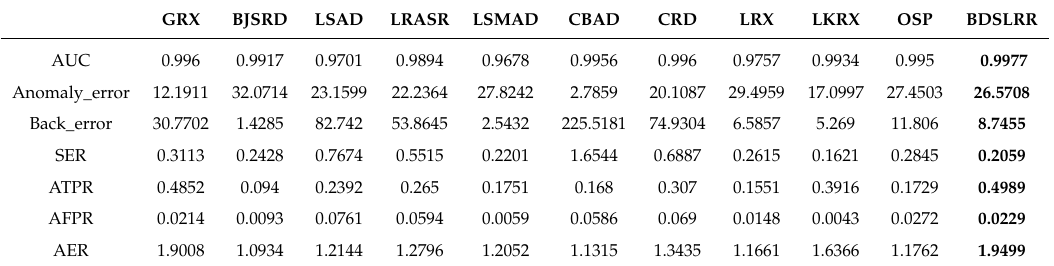
Table 4. Pavia Dataset: Assessment Metric Summary.